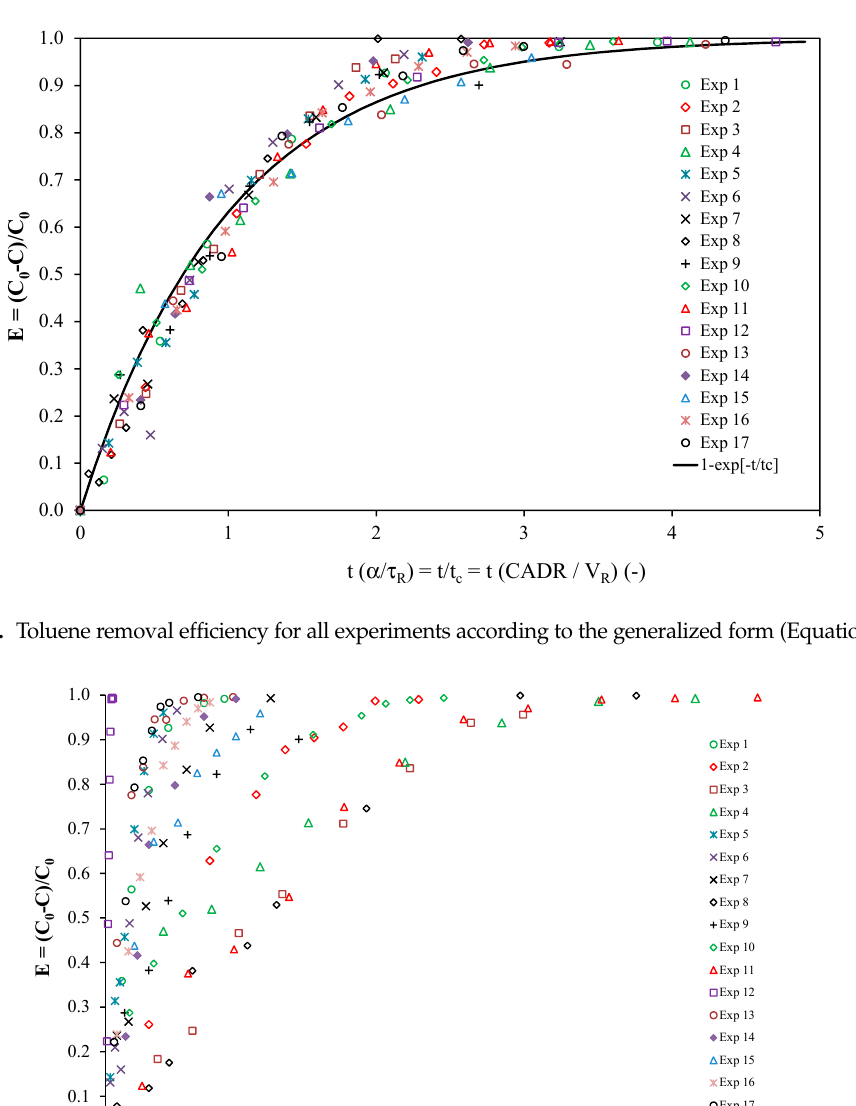
Figure 3. Typical change in toluene concentration over time. Experimental data and models (Exp 10;